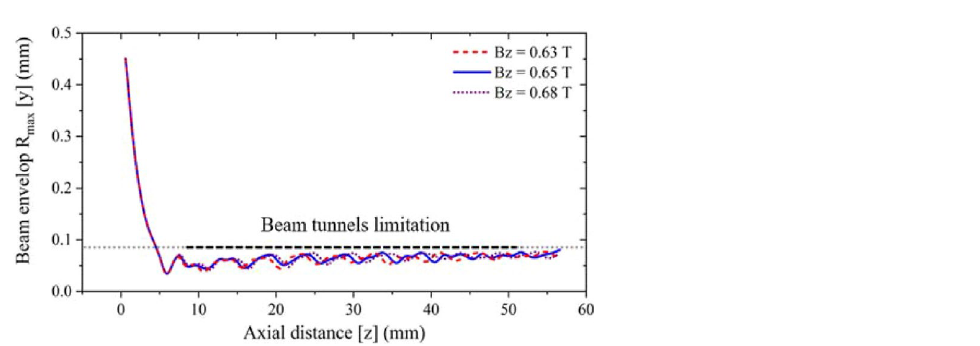
Figure 19. Beam envelope and current result under the uniform magnetic focusing system. ( a ) With the assembly error of 0.2 mm. ( b ) With the driven voltage fluctuation of ± 0.5 kV.